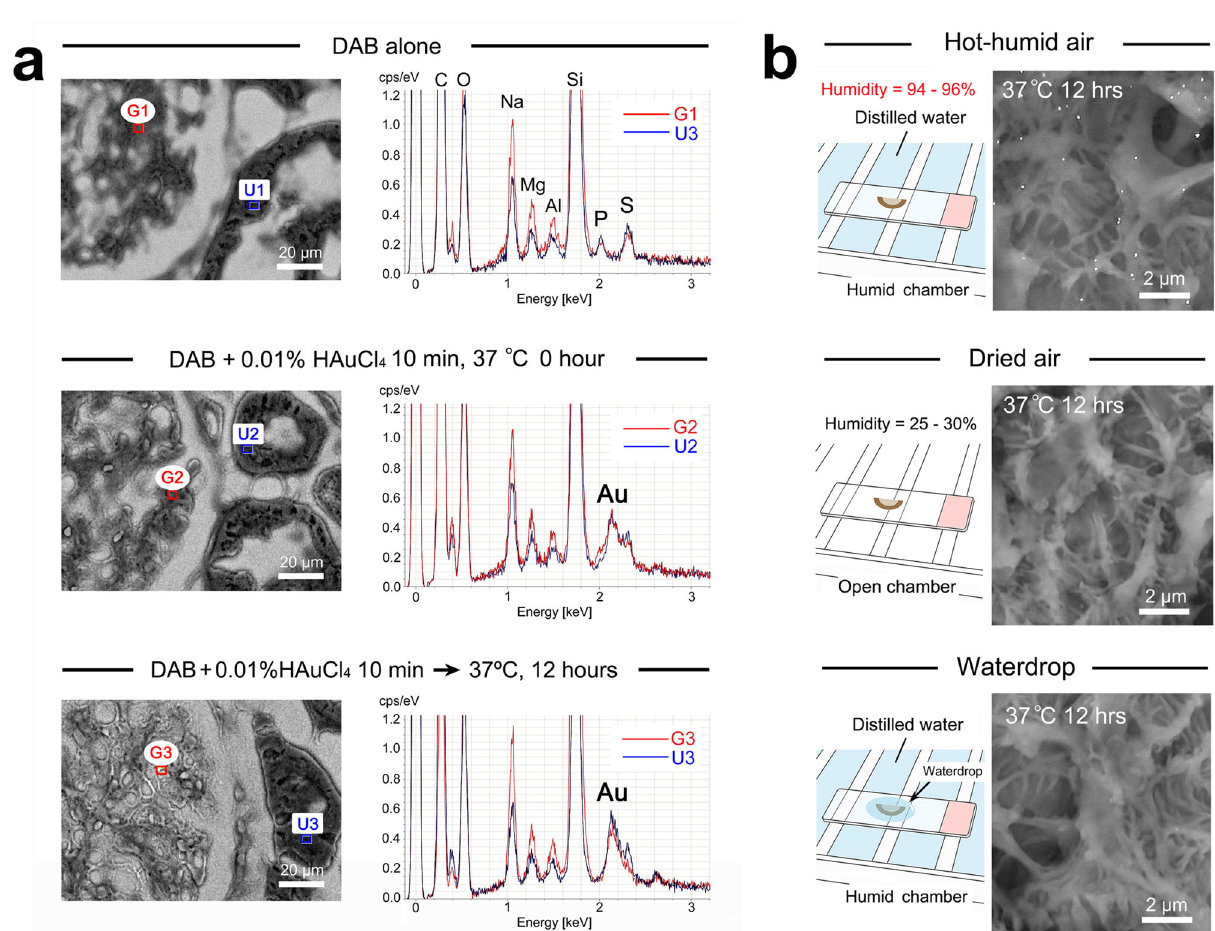
Fig. 5 Elemental analysis of Au distribution in the HAuCl 4 -treated sections and conditioning for secondary growth. a A clear Au peak emerged after treatment with 0.01% HAuCl 4 for 10 min compared with negative control of DAB alone. The Au peak levels were irrelevant to DAB deposition and equally observed in the glomerulus (G2) and uriniferous tube (U2). Note the unchanged Au peak pattern at G3 and U3 after hot-humid incubation at 37 °C for 12 h. G: glomerulus. U uriniferous tube. b Conditioning for secondary growth. Distinct nanogold particles were developed in high-humidity air but not dried air or waterdrops and were incubated at 37 °C for 12